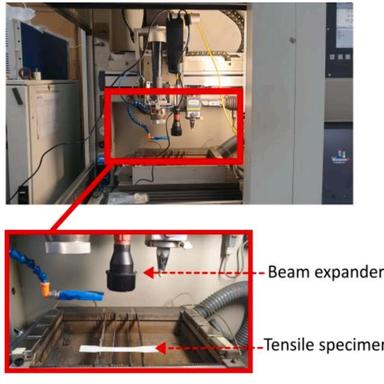
Irradiation test setup.